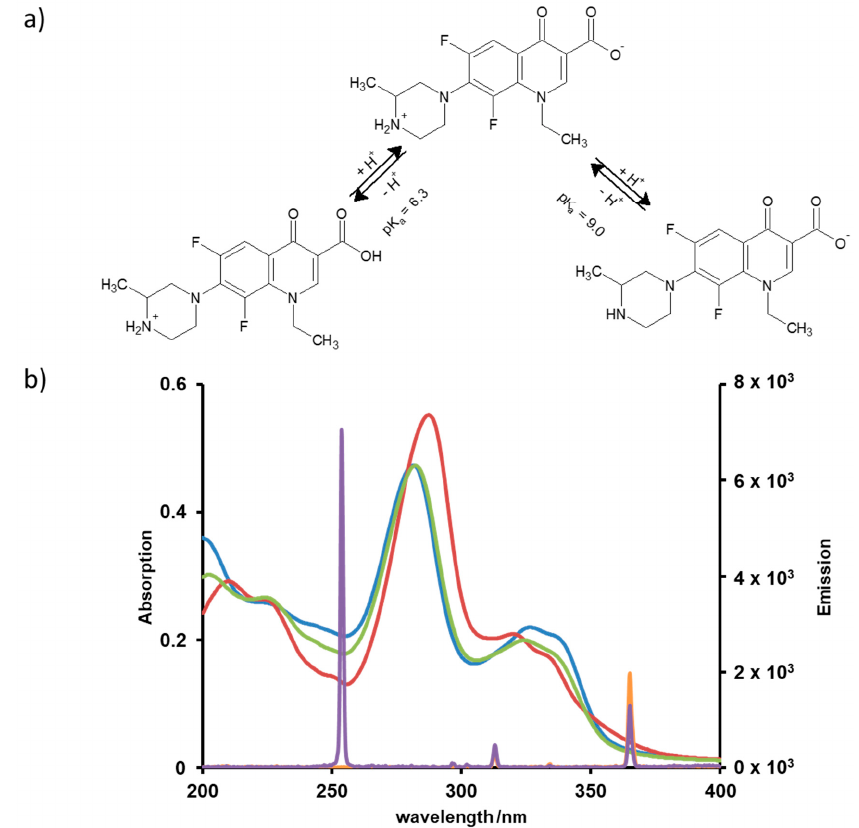
Figure 2. ( a ) pH dependent protonation and deprotonation of LOM; ( b ) Absorption spectra of LOM at pH 3 (red), pH 7 (green) and pH 9 (blue) compared to the emission spectra of the UVA (orange) and UVC lamp (purple).